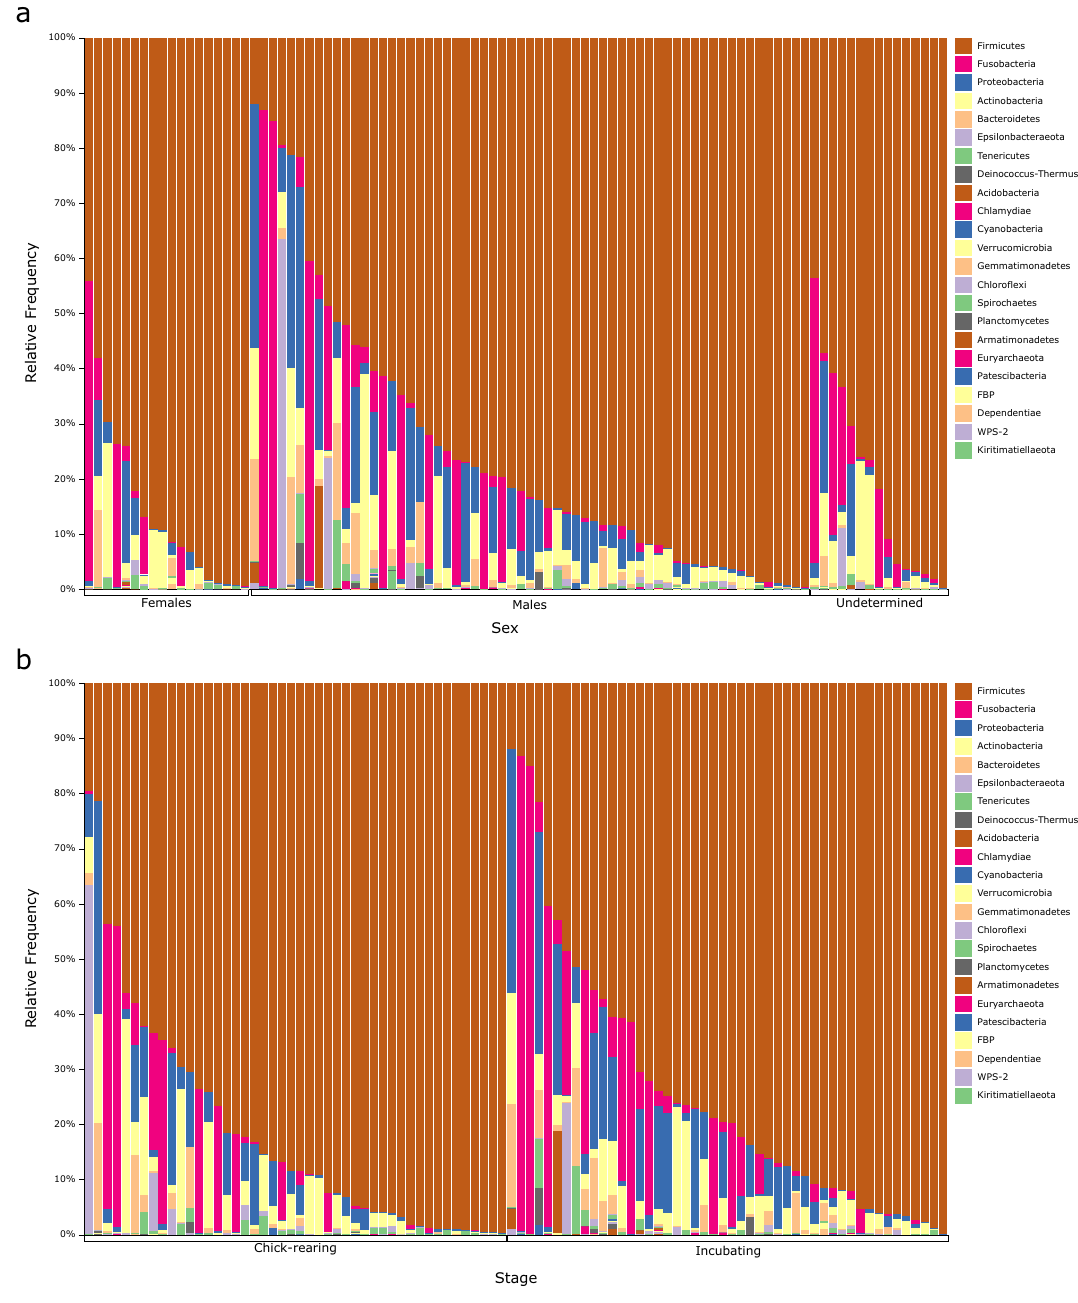
Figure 1. Taxonomic classification at the Phylum level of the ASVs obtained from murre fecal samples showing a strong influence of bacteria belonging to the Phylum Firmicutes. Samples were grouped by ( a ) sex of the sampled bird or ( b ) the reproductive stage at which the bird was during